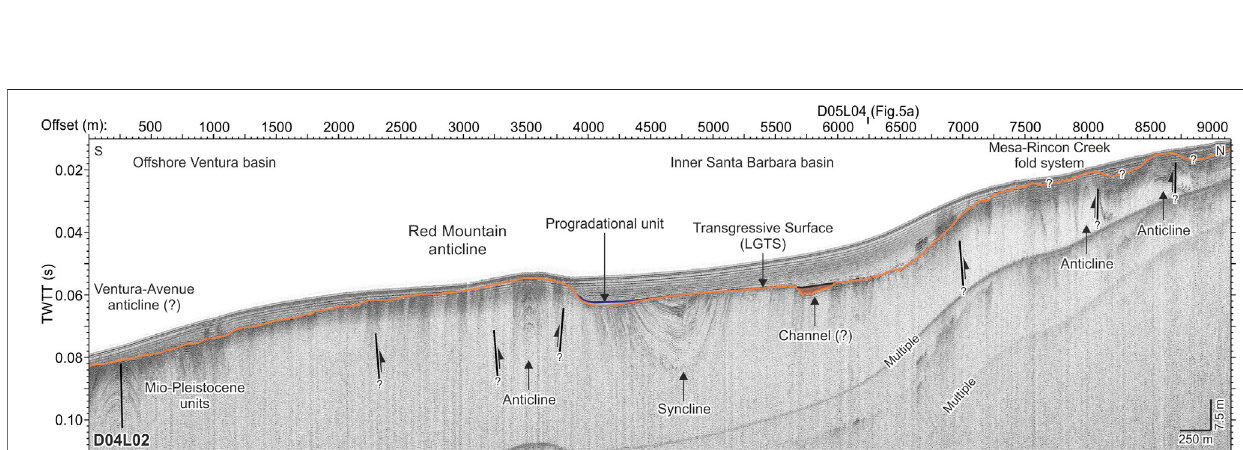
Frontiers in Earth Science |